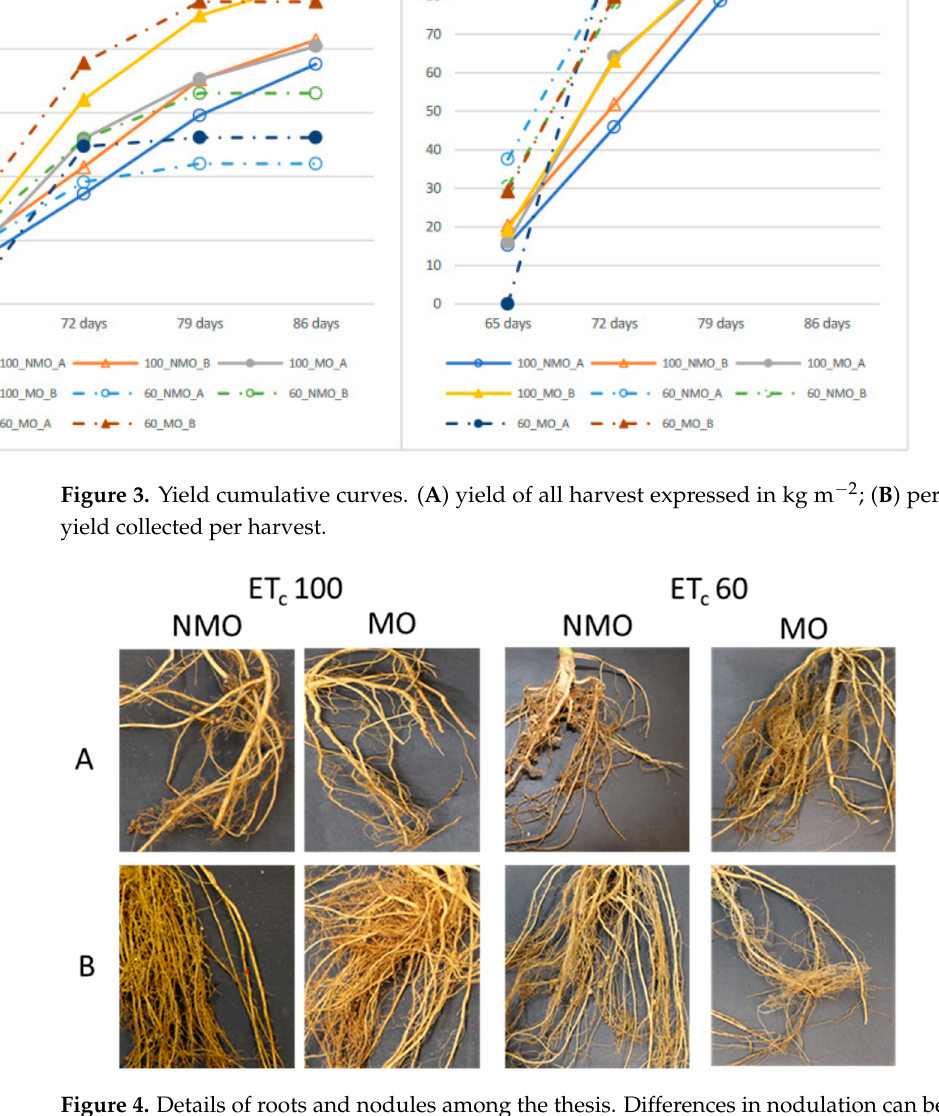
Figure 4. Details of roots and nodules among the thesis. Differences in nodulation can be observed between the two different irrigation regimes (ETc 100 and ETc 60), by application of PGPMs (MO